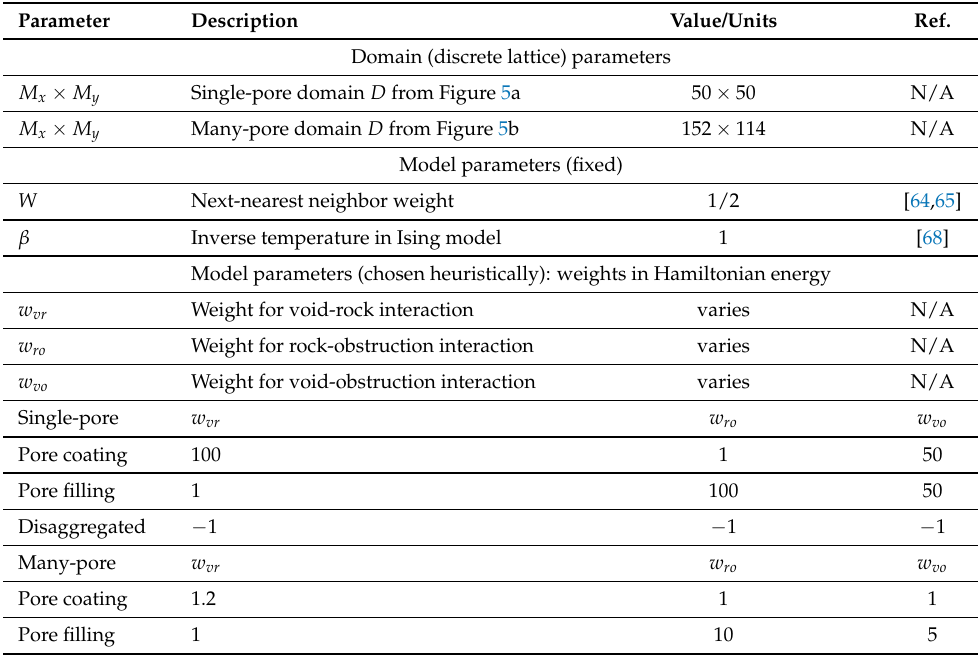
Table 4. Parameters for the reduced model LP used in single-pore and many-pore experiments in Section 5.2. This lattice model uses no physical